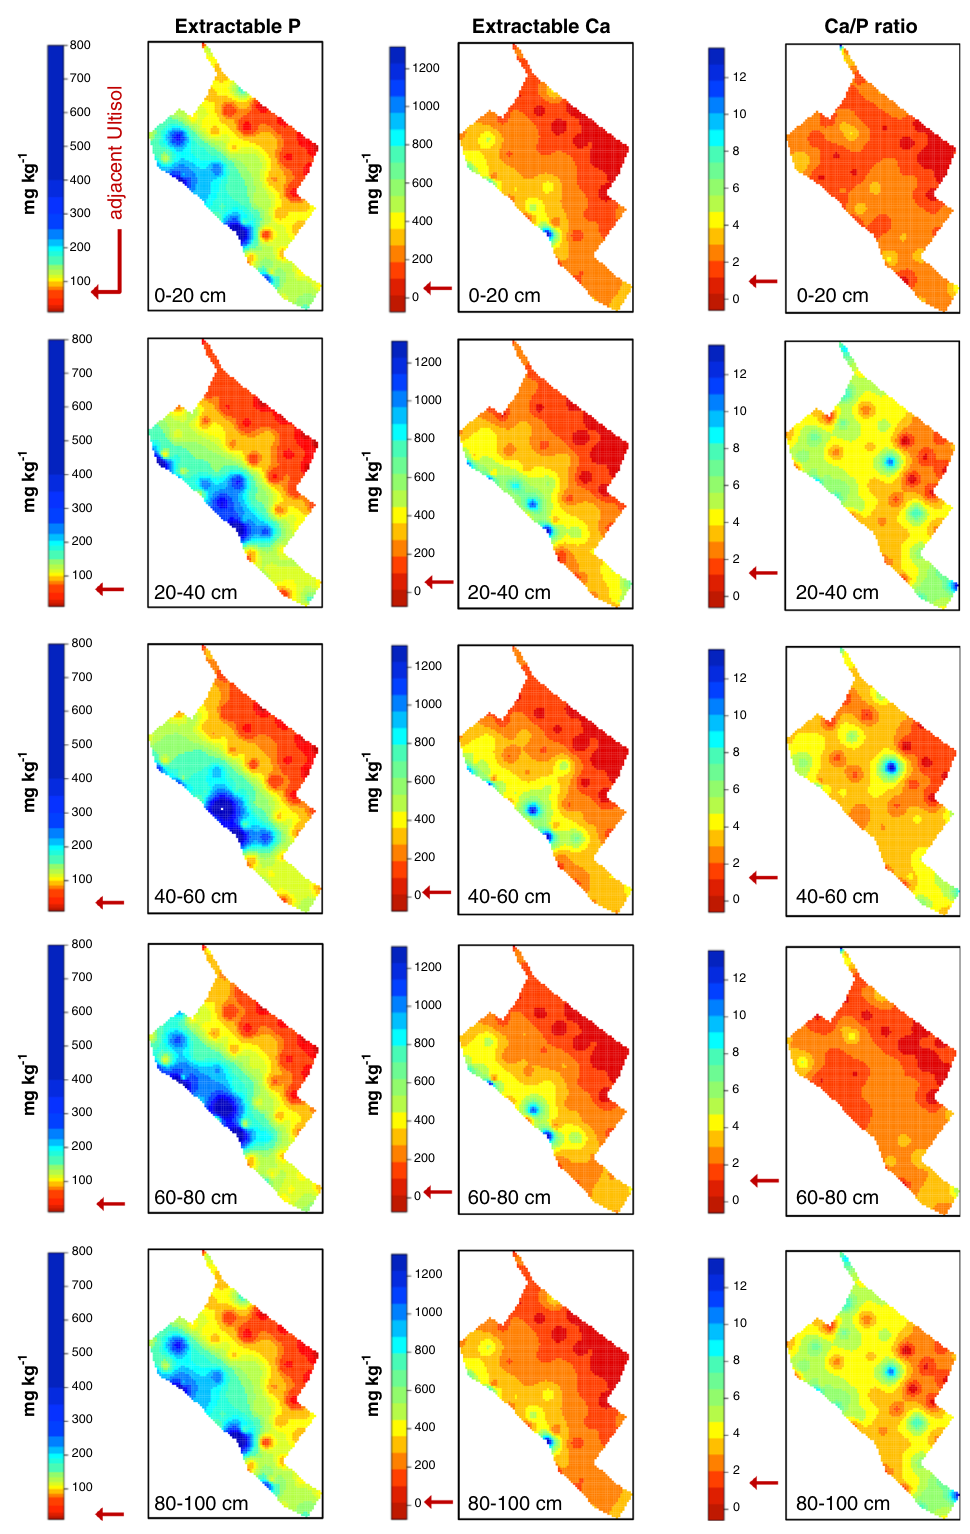
Fig. 2 Concentration of extractable phosphorus (P) and calcium (Ca) and their ratios in ADE and Ultisol pro fi les. Spatial interpolation maps developed using fi rst-order kriging of reference pro fi les (white circles; Fig. 1) indicate a depositional gradient from ADEs near the paleochannel levee toward nutrient- poor Ultisols. Red arrows indicate approximate values measured in the adjacent maximum contrast Ultisol pro fi les under rainforest (red triangles; Fig.